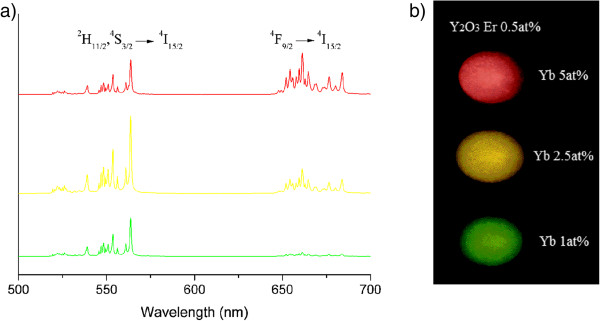
UC spectra of NPs for all dopant compositions and photograph of pellets prepared from UCNPs. (a) UC spectra of Y1.97Yb0.02Er0.01O3 (green line), Y1.94Yb0.05Er0.01O3 (yellow line), and Y1.89Yb0.10Er0.01O3 (red line) NPs. (b) Photograph of pellets prepared from UCNPs with different Yb3+ concentrations taken under 978-nm excitation.